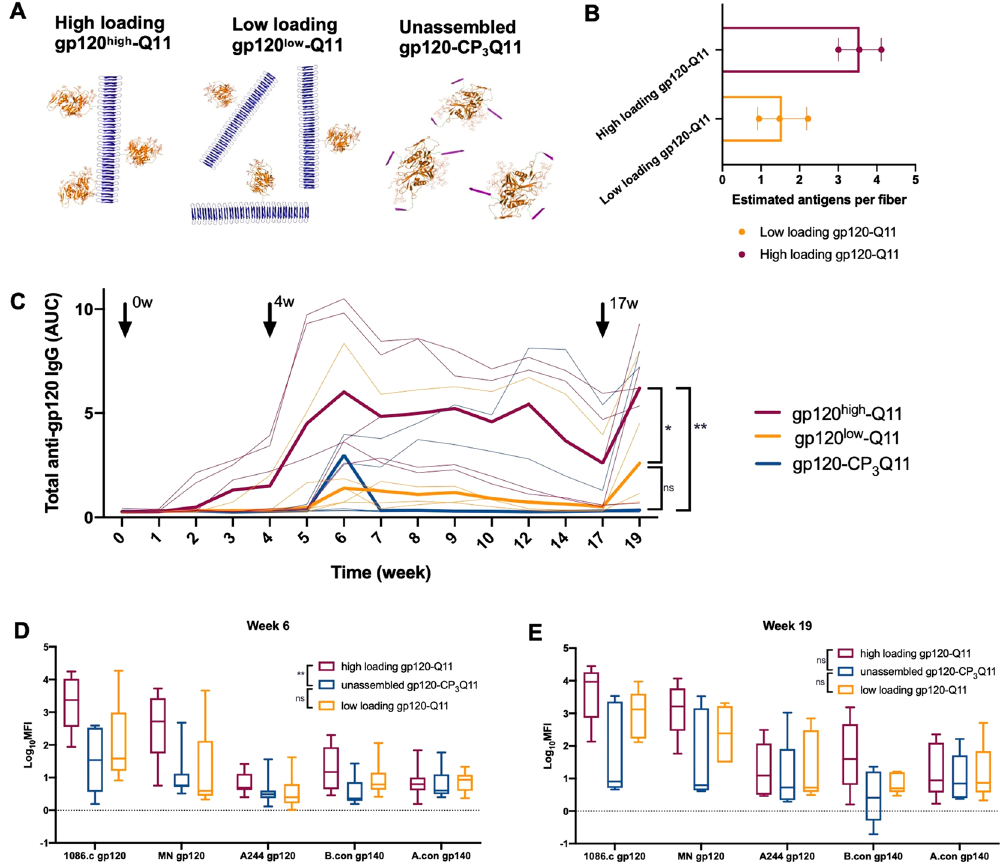
Figure 4. High gp120 antigen density on nanofibers drives increased antibody titer and binding breadth. ( A ) Schematic representation of gp120 nanofibers and unassembled antigens modified with non-assembling peptides. ( B ) Number of gp120 antigens on gp120 high -Q11 and gp120 low -Q11 for 3 immunizations estimated by gp120 concentration and average fiber length. ( C ) Magnitude of serum antibody responses to gp120 from mice immunized with indicated formulations at times indicated by arrows as measured by ELISA. Bold